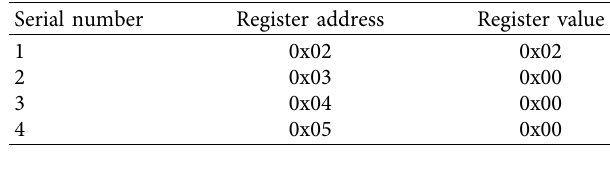
Table 1: Register configuration content.